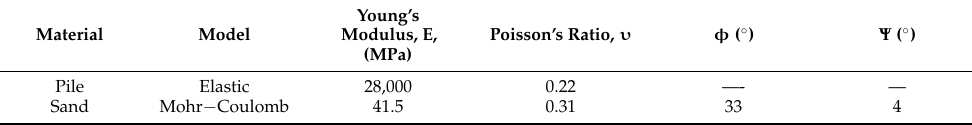
Table 5. Materials used in the numerical modelling.